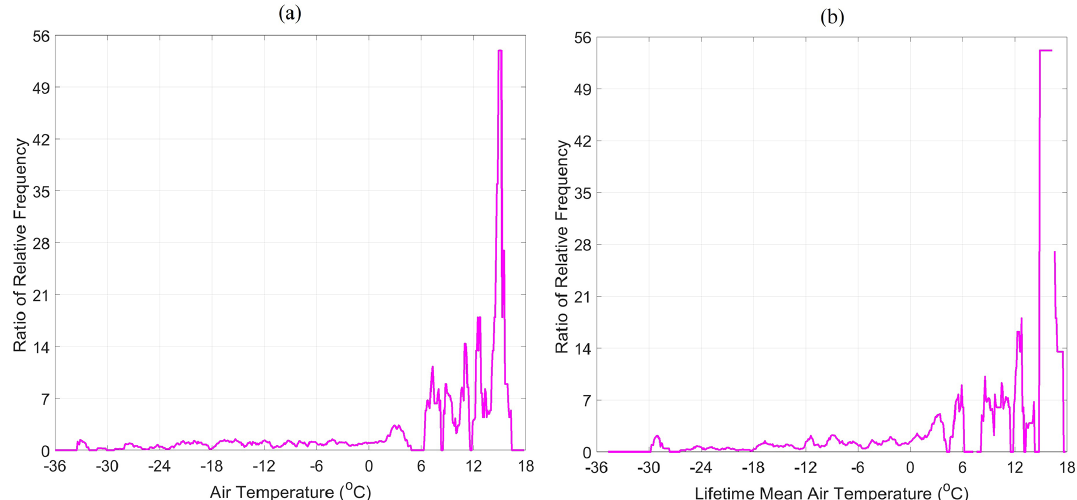
Figure A2. The ratio of the relative frequency for fracture events and all observations over the range of air temperature (a) and lifetime mean air temperature (b) that surrounded the Petermann ice islands. Values close to 1 imply that fracture events are as likely to occur as the frequency of observations. Values larger than 1 indicate that fracture events are more likely to occur than the frequency of observations. Values less than 1 imply that fracture events are less likely to occur relative to the frequency of